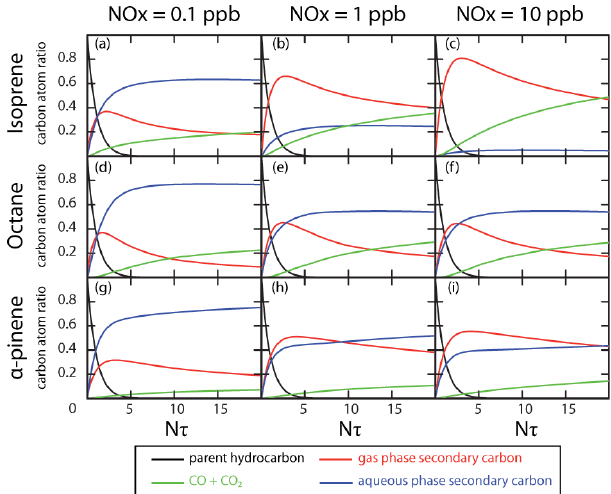
Fig. 2. Carbon budget during the oxidation of isoprene (top line), octane (middle line) and α -pinene (bottom line) for a NO x concen- tration of 0.1ppb (1st column), 1ppb (2nd column) and 10ppb (3rd column), with a cloud liquid water content ( L = 3 × 10 − 7 ) . The time scale is described in the